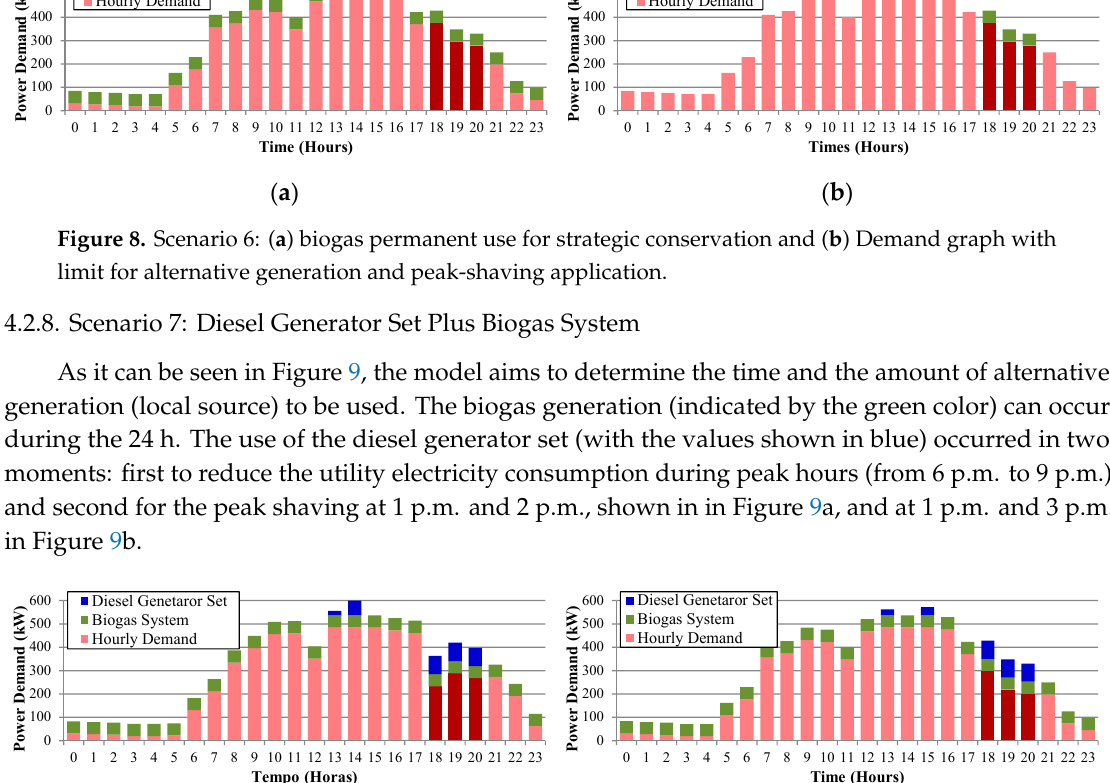
Table 10. Main results for Scenario 6.